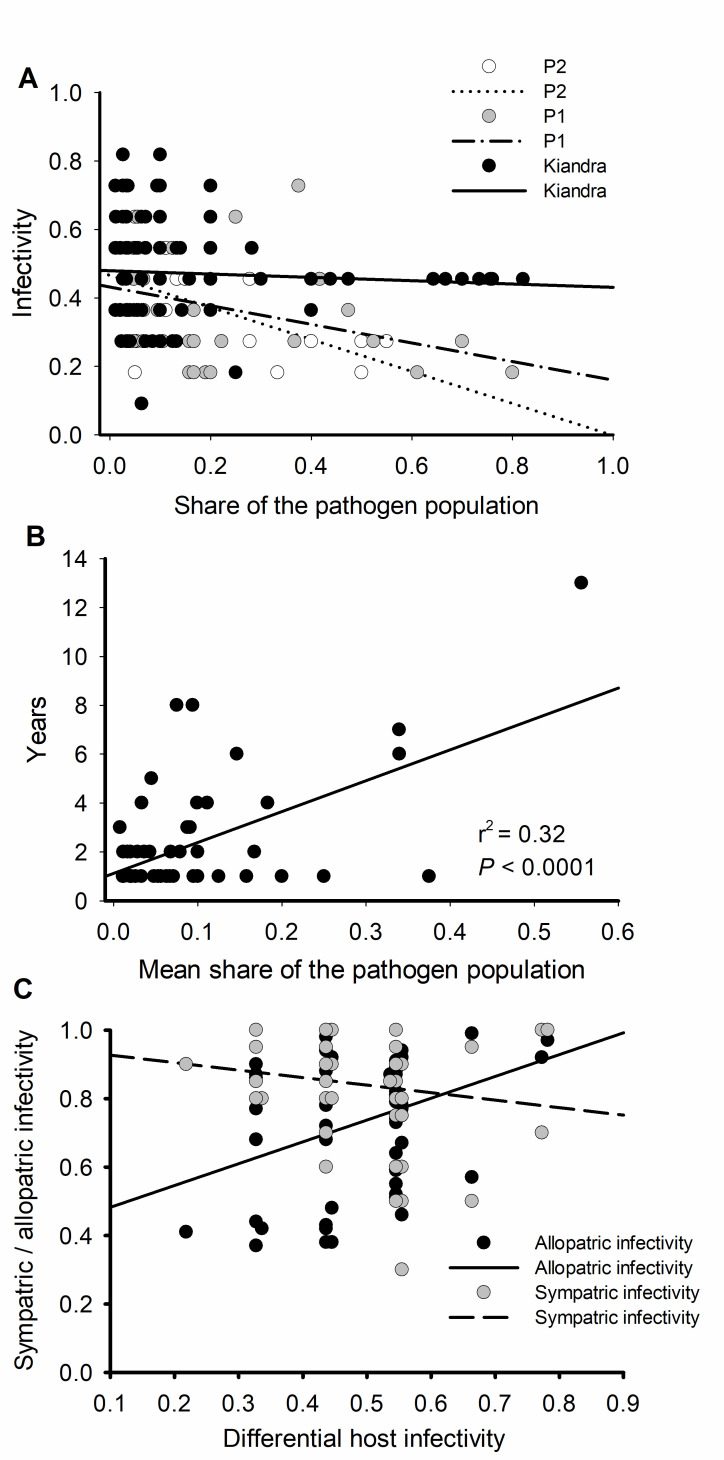
Linking Melampsora lini pathotype infectivity and share of the population.(A) Correlation between Melampsora lini pathotypes share of the population in three populations, Kiandra, P1 and P2, and infectivity over the Linum marginale differential host set. (B) Correlation between the pathotype’s mean share of the population and years of prevalence in the population. (C) Correlation between the differential set measured pathogen infectivity and infectivity measured using sympatric hosts (grey circles, dashed line) and allopatric hosts (black circles, solid line).